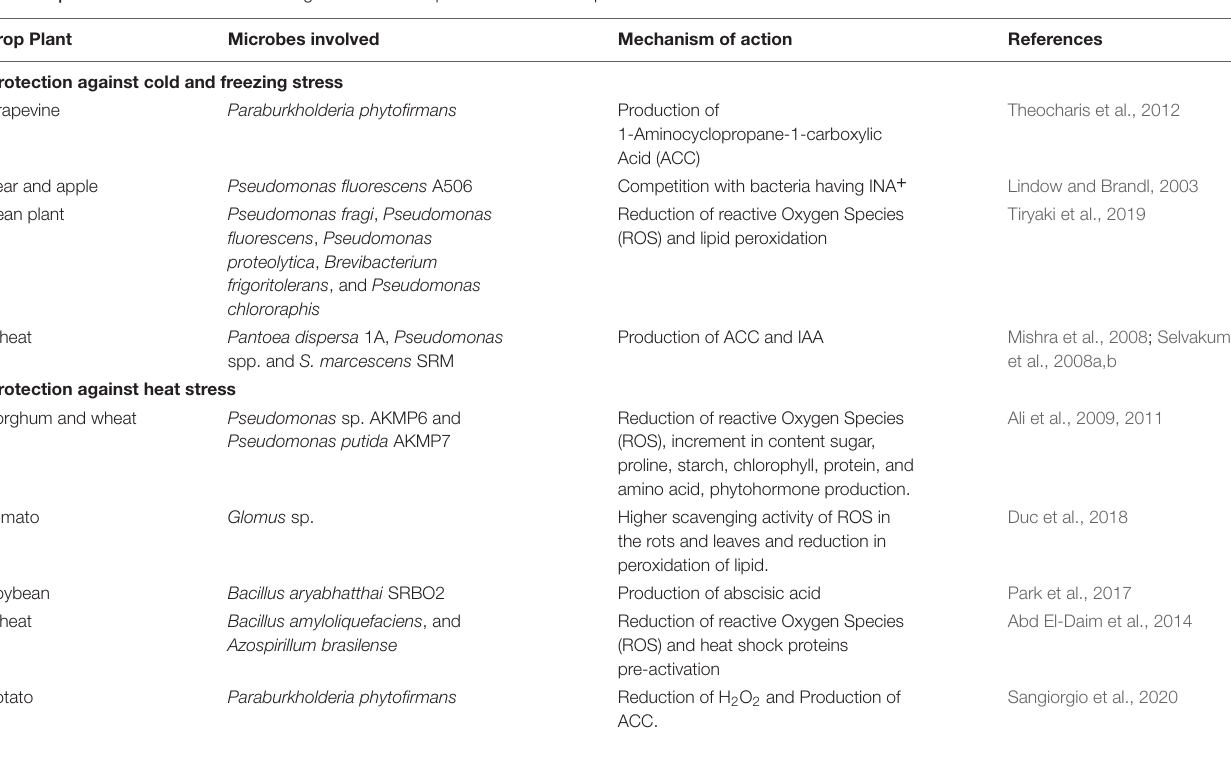
TABLE 1 | Microbial biostimulants that mitigate extreme temperature stress in